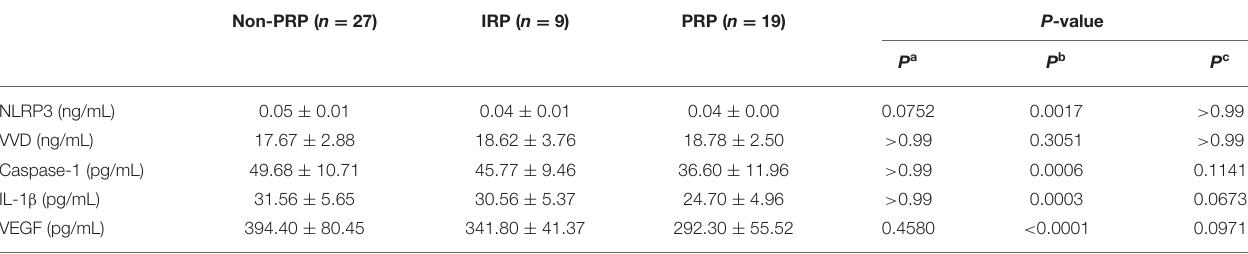
TABLE 3 | Level of inflammatory factor and vitreous 25 (OH) D in PDR patients according to pan-retinal laser photocoagulation